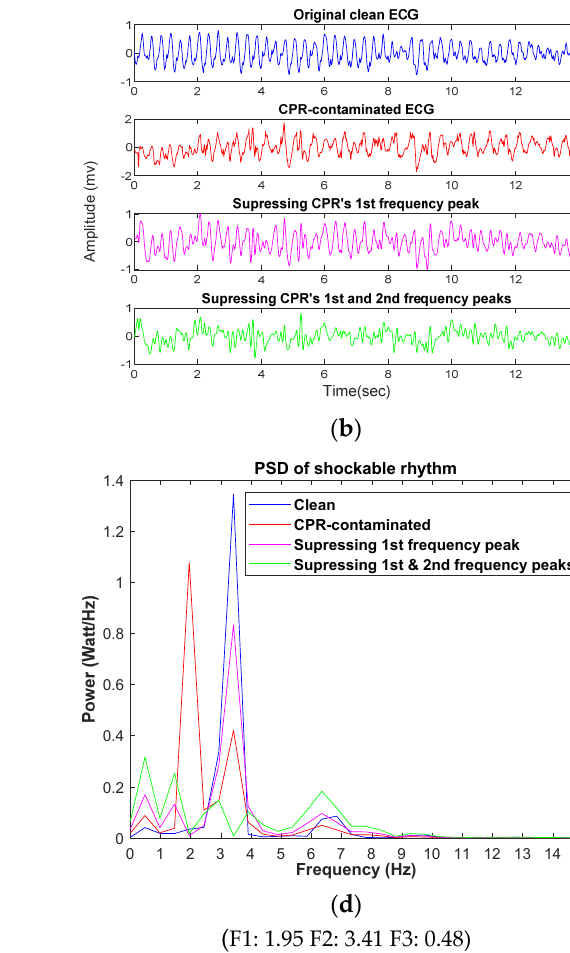
Figure 3. ( a ) Non-shockable ECG sample and ( b ) shockable ECG sample—1st row: desired clean ECG, 2nd row: CPR- contaminated ECG, 3rd row: filtered ECG after removing highest frequency peak, 4th row: filtered ECG after removing both highest and 2nd frequency peaks. ( c ) PSD plots of non-shockable ECG sample and ( d ) PSD plots of shockable ECG sample. The PSD of the desired clean ECG, CPR-contaminated ECG, filtered ECG after removing highest frequency peak, and filtered ECG after removing both highest and 2nd frequency peaks are plotted in blue, red, purple, and green, respec- tively.